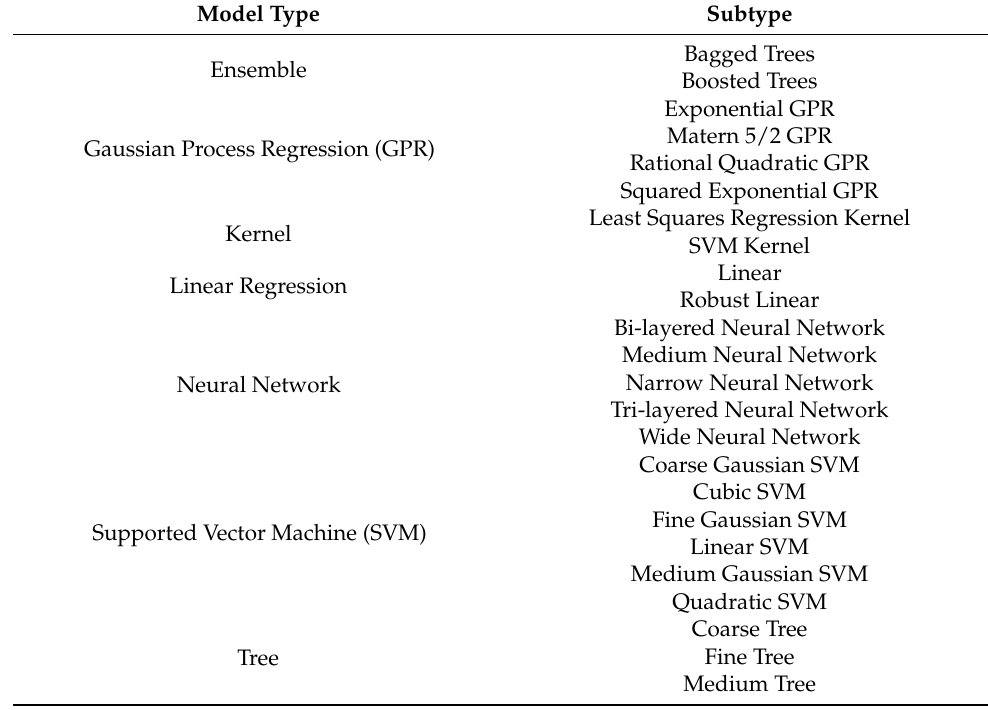
Table 6. Tested fitted regression